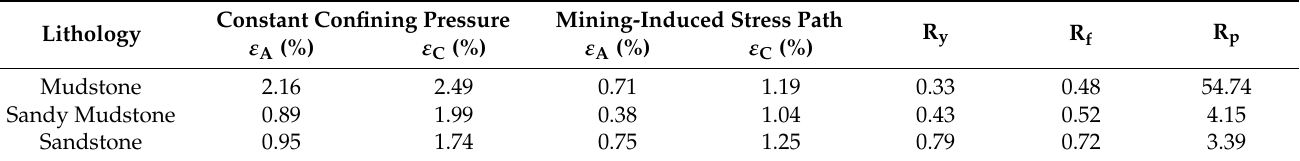
Table 2. Variation of strain and permeability in each stage of two loading